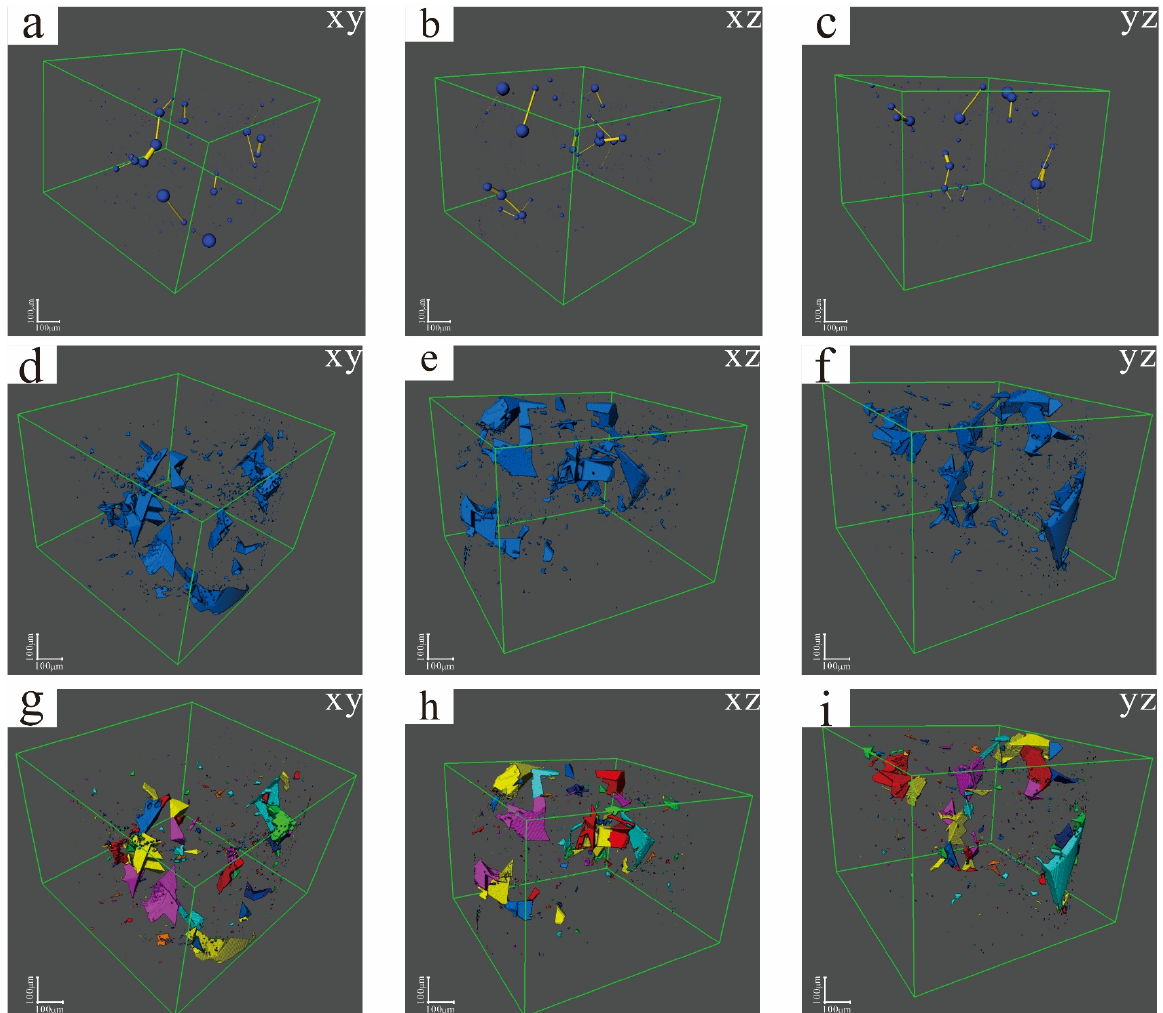
Figure 13. Pore and pore throat structure imaging of sample HZ-9: ( a – c ) the blue spheres represent the pores, and the yellow lines represent the pore throats; ( d – f ) blue represents the spatial position of the pores and pore throats; ( g – i ) the pores with similar colors in adjacent regions are connected. The micro-CT scan of sample HZ-12 is shown in Figure 14, in which the black part represents the pores, and the gray part represents the rock matrix. Although HZ-12 had fewer pores, there were some dispersed macropores.